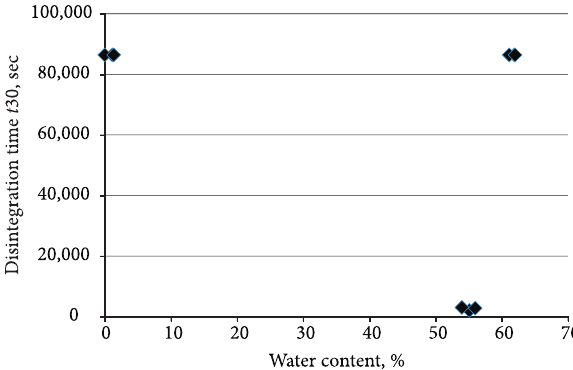
Fig. 10. Disintegration time t material